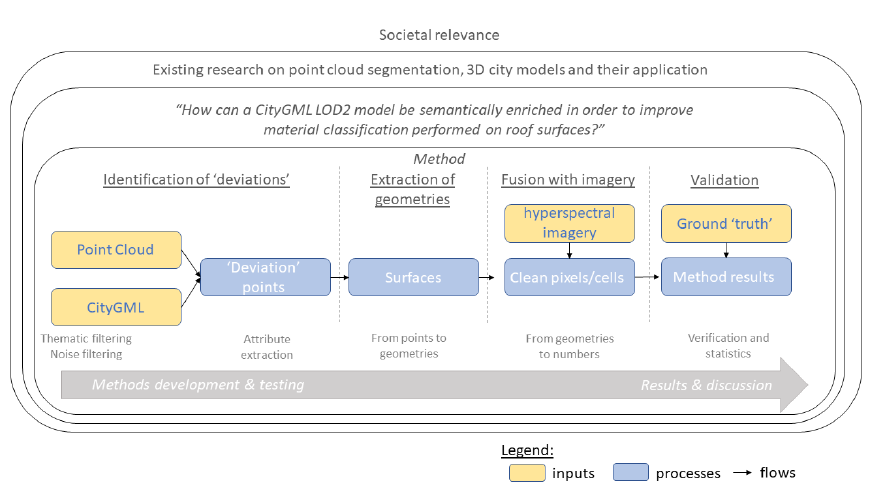
Figure 1. Framework of the research method in this paper (‘clean’ pixels are pixels containing a single material)